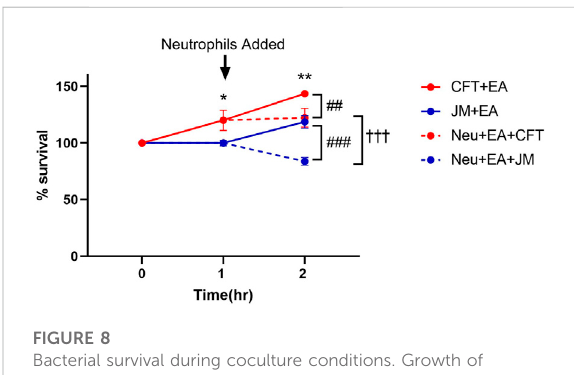
FIGURE 8 Bacterial survival during coculture conditions. Growth of CFT073andJM109bacteriaincocultureconditionswereanalyzed by plating on LB agar plates as described in “ Materials and Methods ” .Bacteriasurvival%wascalculatedcomparedtothe starting bacteria in the cultures. Data represent average of 3 biological replicates. Statistics were performed using unpaired t -test and one way ANOVA. p value: ** p < 0.01, * p < 0.05 indicate CFT073 cocultured with endothelial cells (EA) compared